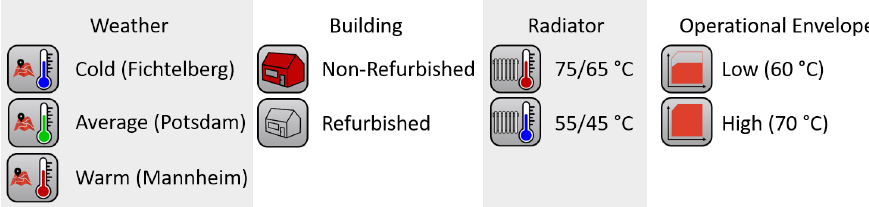
Figure 4. The simulation study considers different combinations of weather, building, radiator, and operational